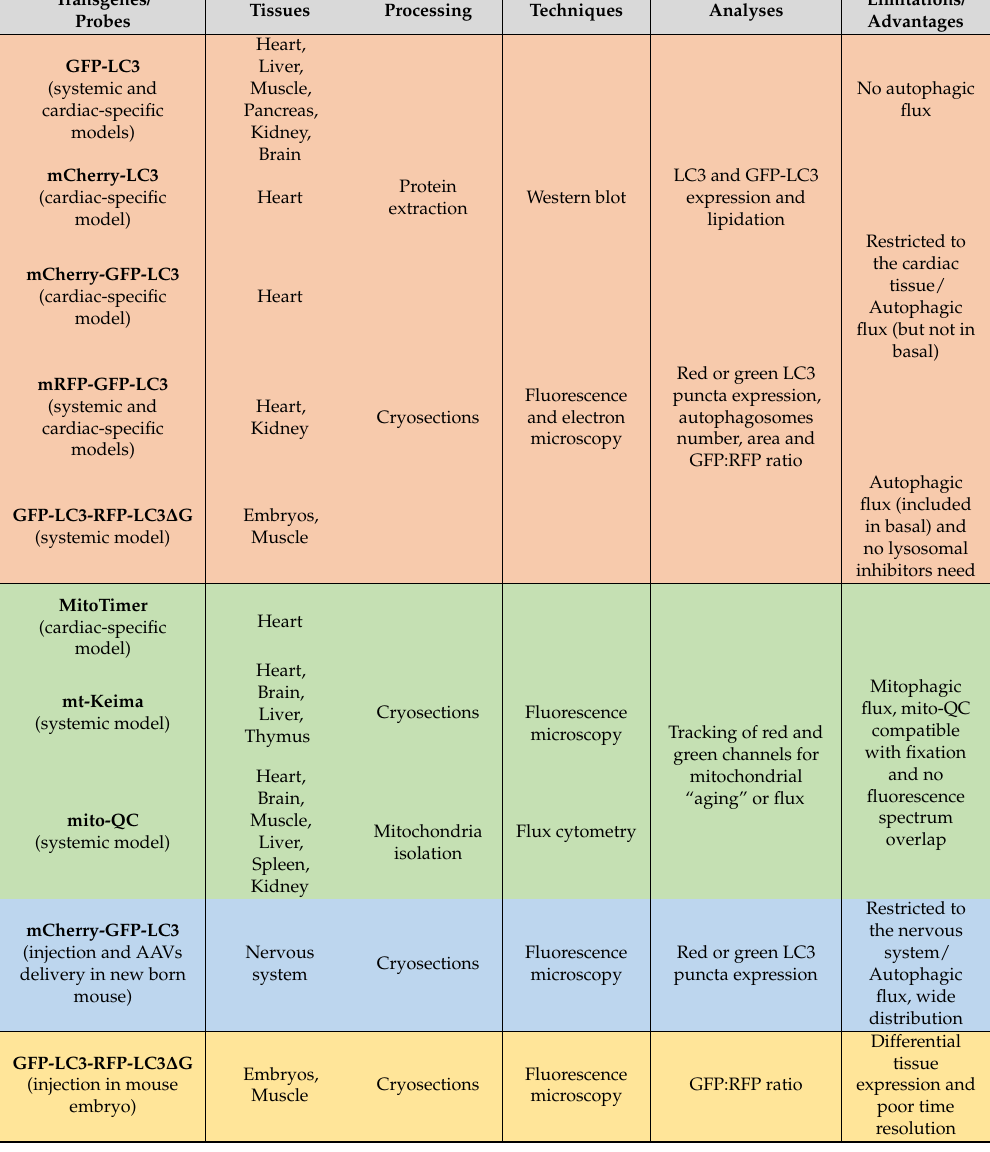
Table 1. Transgenic mouse models for monitoring